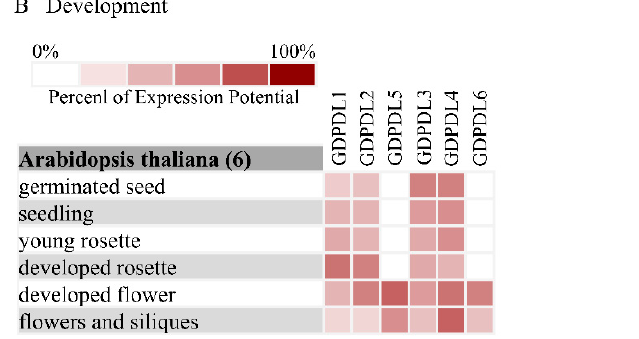
Figure 4. Analysis in silico of the expression of GDPDL-RLPs. ( A ) The expression profile of the GDPDL-RLPs in response to pathogens. ( B ) The expression profile of the GDPDL-RLPs in different organs and developmental stages.